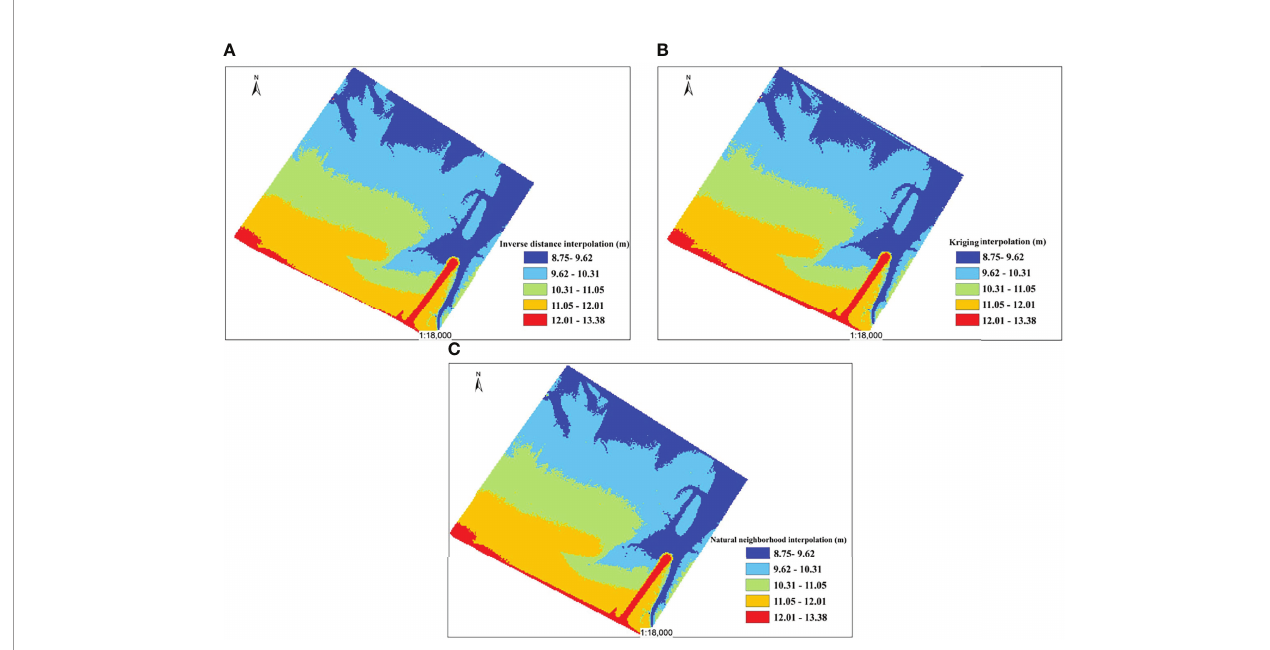
FIGURE 10 | DEM shading map of tidal fl at. (A) Inverse distance interpolation; (B) Kriging interpolation; and (C) Natural neighborhood